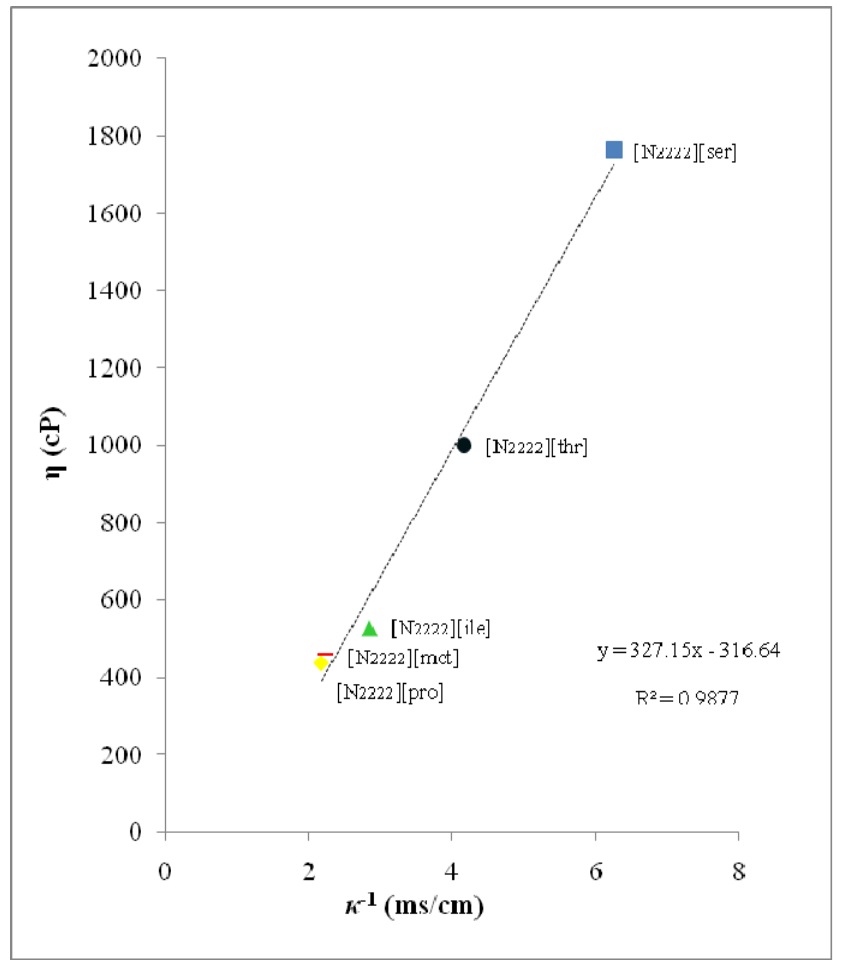
Figure 2. Relationship between ionic conductivity ( κ -1 ) and viscosity ( η ) for five tetraethylammonium-based chiral ionic liquids at 25